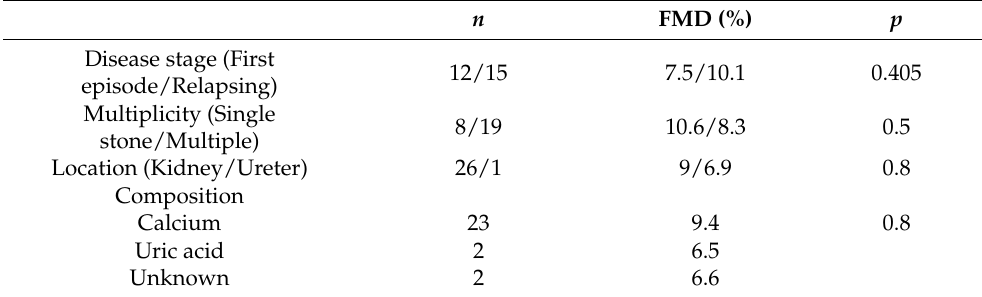
Table 5. Univariate analysis between stone characteristics and (FMD%) (Student’s t -test and ANOVA